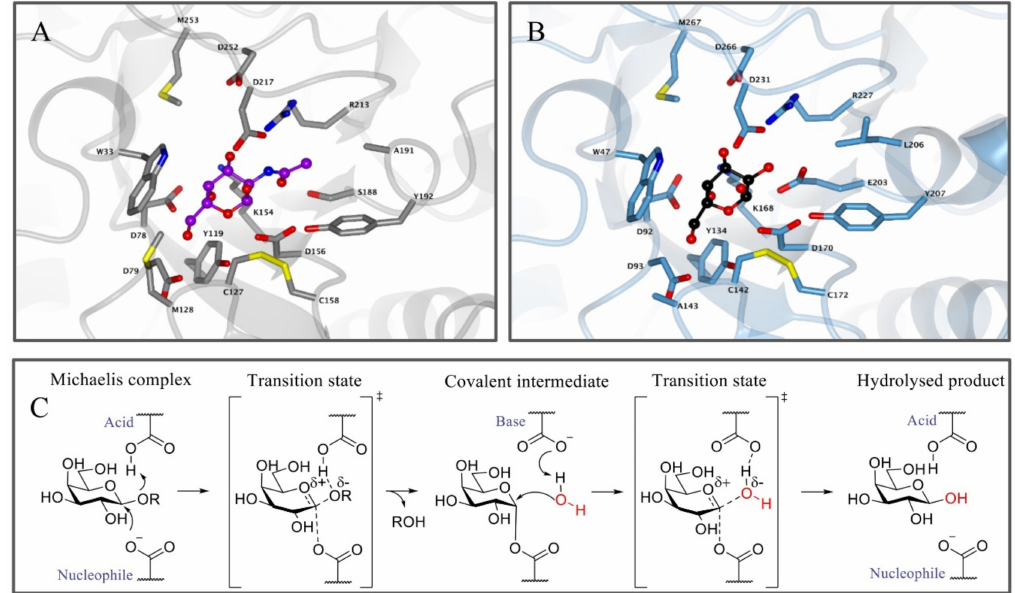
Figure 1. Enzyme structure and reaction mechanism of α -N-acetylgalactosaminidase ( α -GalB) and α -galactosidase A ( α -GalA). ( A ) Active site of α -GalB (gray) with GalNAc (blue) bound in the pocket. ( B ) Active site of α -GalA (blue) with galactose (black). Larger C-2 substituents cannot be accommodated in α -GalA due to the presence of residues L206 and E203. Structures were obtained from the Protein Data Bank (PDB) IDs 3H55, 3H54 or 3GXP and visualized using CCP4MG. ( C ) Koshland double displacement mechanism of retaining α